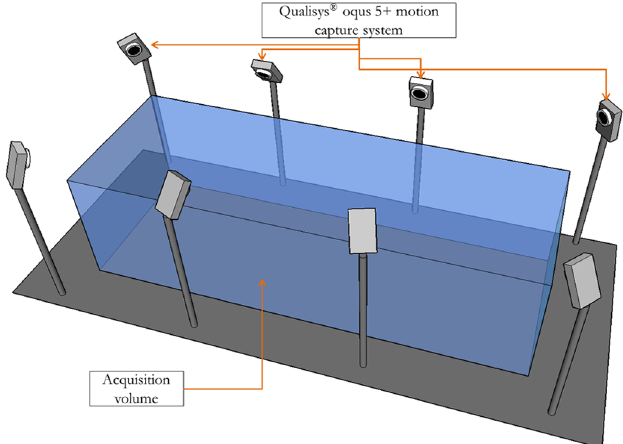
Fig. 19. Motion capture system simulation with visualization of the acquisition volume (blue)